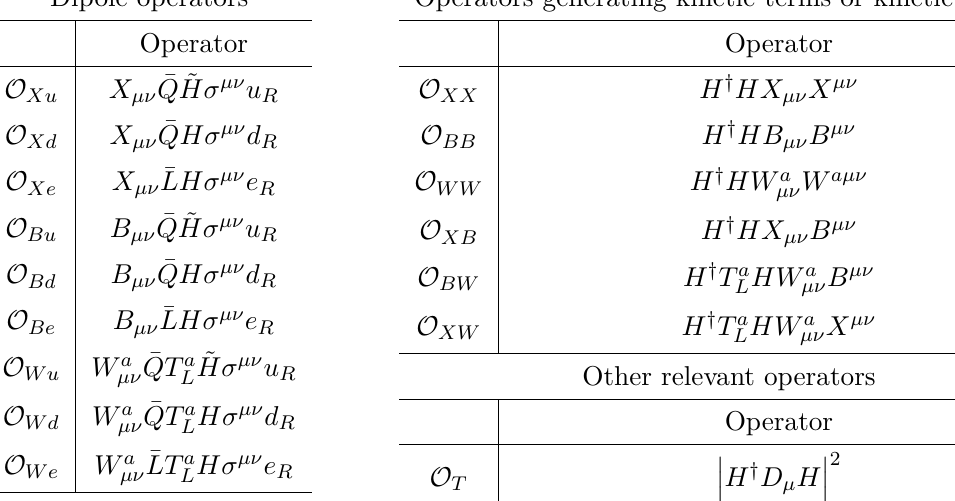
symmetry is denoted by X . The symbol T a X ] = δ ab / 2 , T b L L